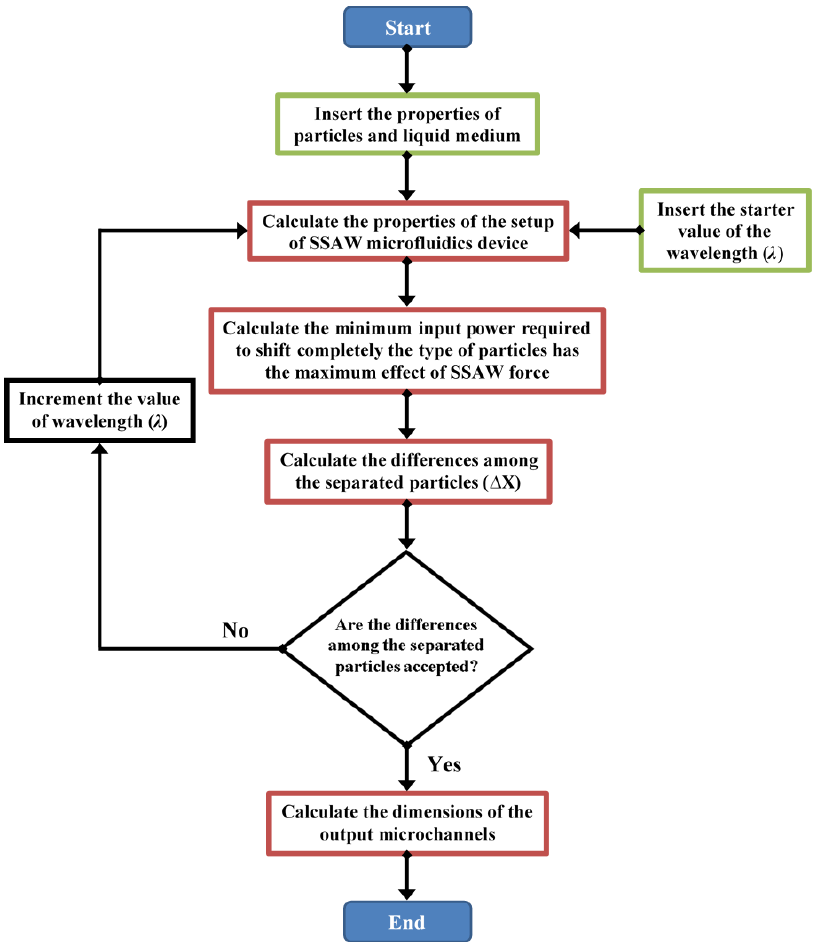
Figure 4. The flow chart of proposed design analysis of SSAW microfluidics for specific Figure separation process.